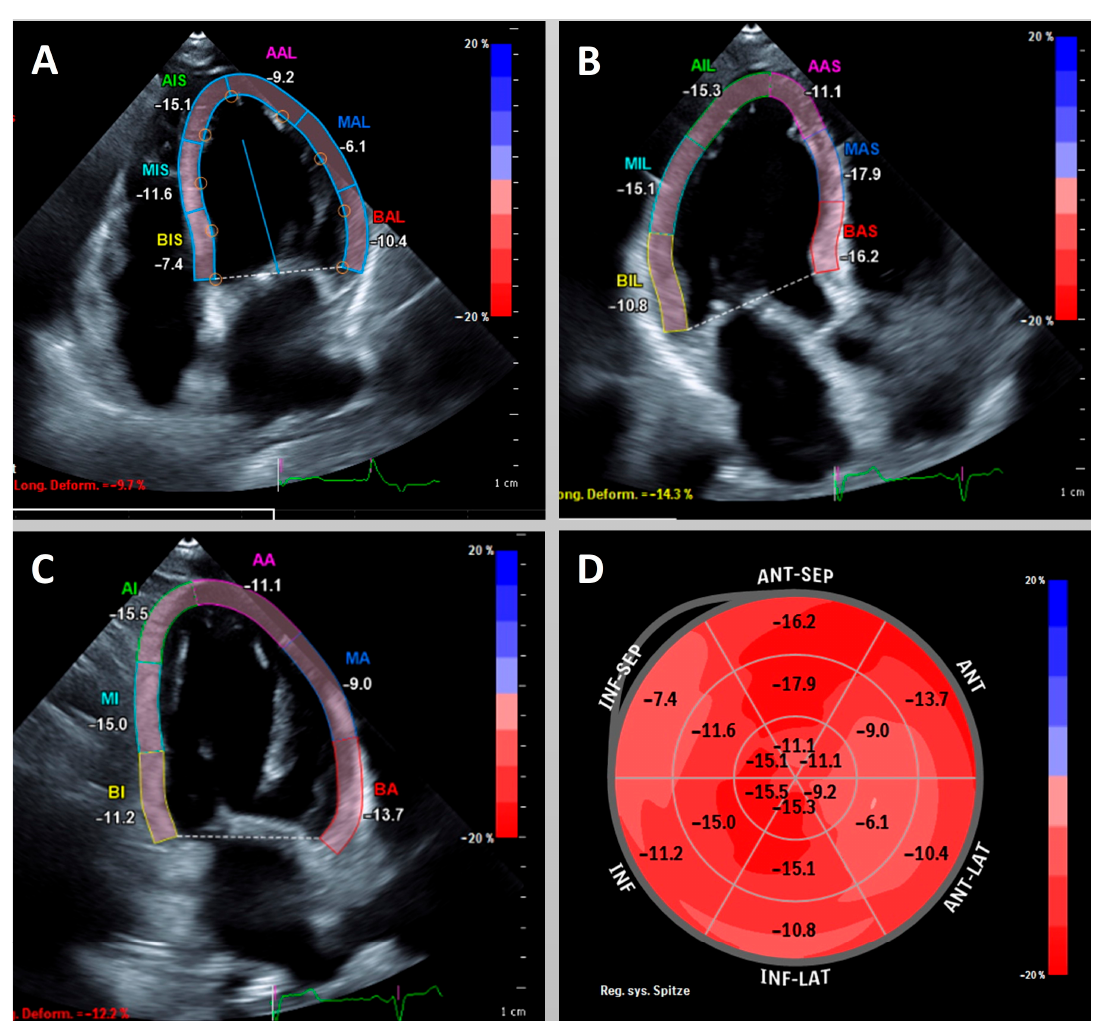
Figure 1. Example of a patient with reduced left ventricular global longitudinal strain (GLS) of − 12.1%. Apical 4-, 3- and 2-chamber view ( A – C ) with highlighted left ventricular myocardium. Bullseye plot ( D ) shows globally reduced longitudinal strain with accentuation basally septal and midventricular anterior/anterolateral.